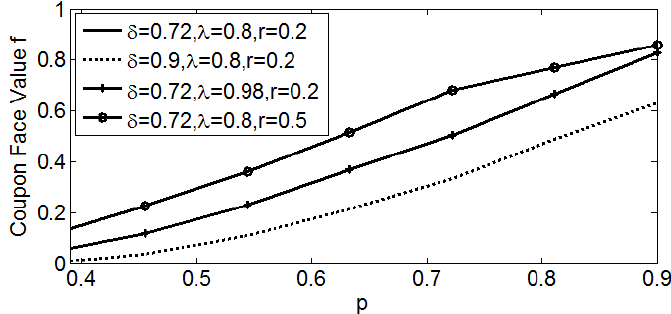
Figure 9. Impacts of p , δ , λ and r on coupon face value.